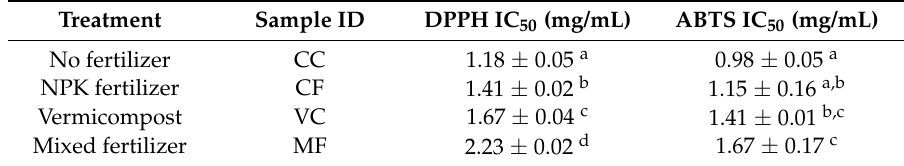
Table 3. Effect of plant growth supplements on antioxidant potential of methanolic extracts of C. nutans